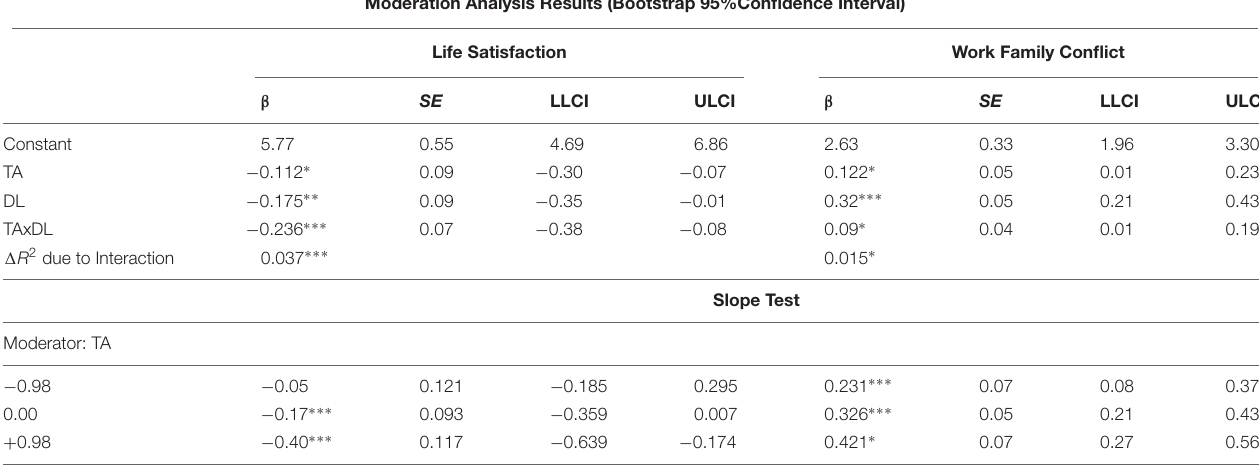
TABLE 5 | Moderation